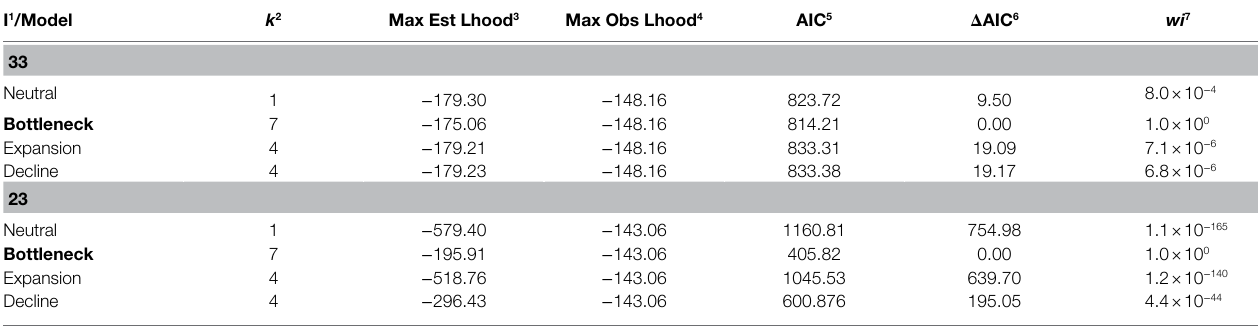
TABLE 2 | Comparison among demographic models for the M. catharinensis